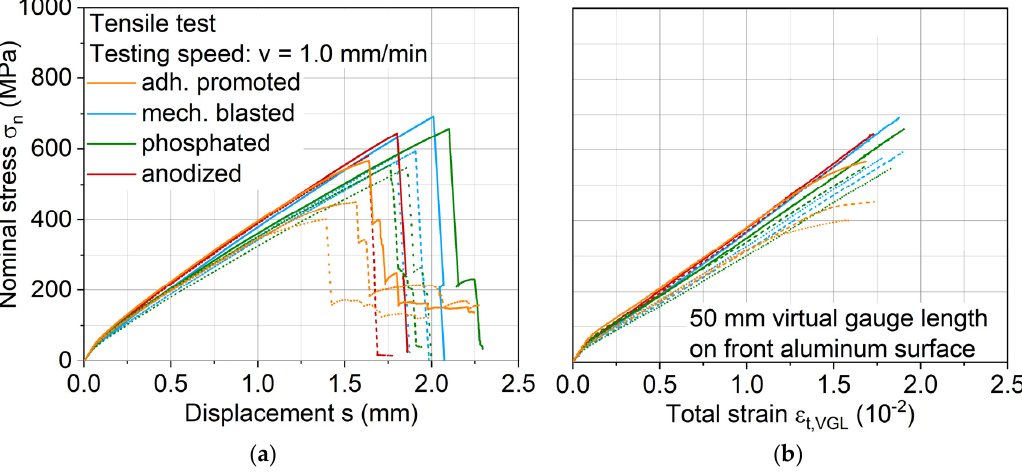
Figure 7. ( a ) Stress-displacement curves and ( b ) stress-strain curves of hybrid laminates with surface- treated aluminum alloy AA6082-T4 and a graded structure of glass and carbon fiber-reinforced PA 6 in a 2/1 configuration. The curve color represents an aluminum surface treatment variant of the hybrid laminate; dotted lines represent different specimens.